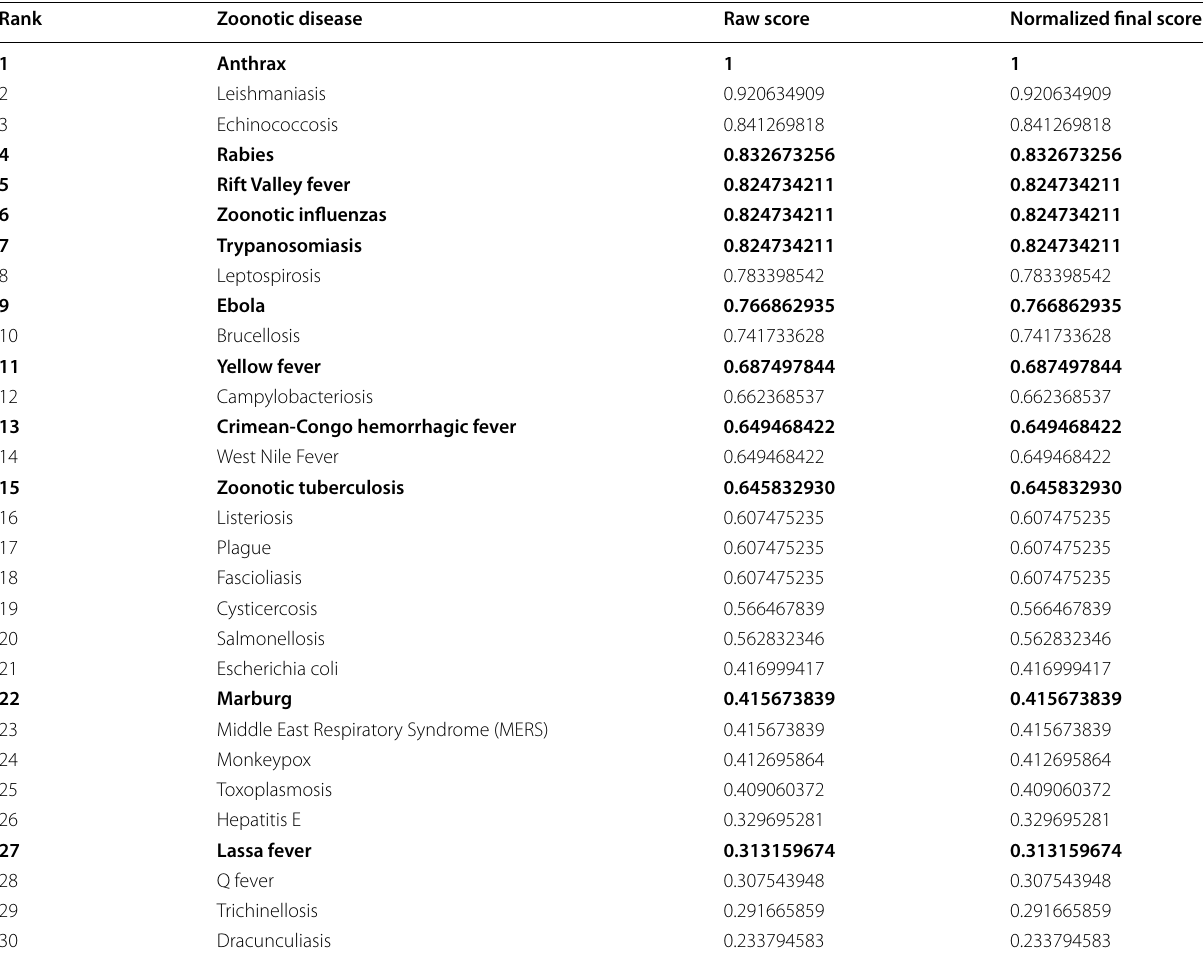
Table 2 Final ranked zoonotic diseases, raw scores, and normalized final scores